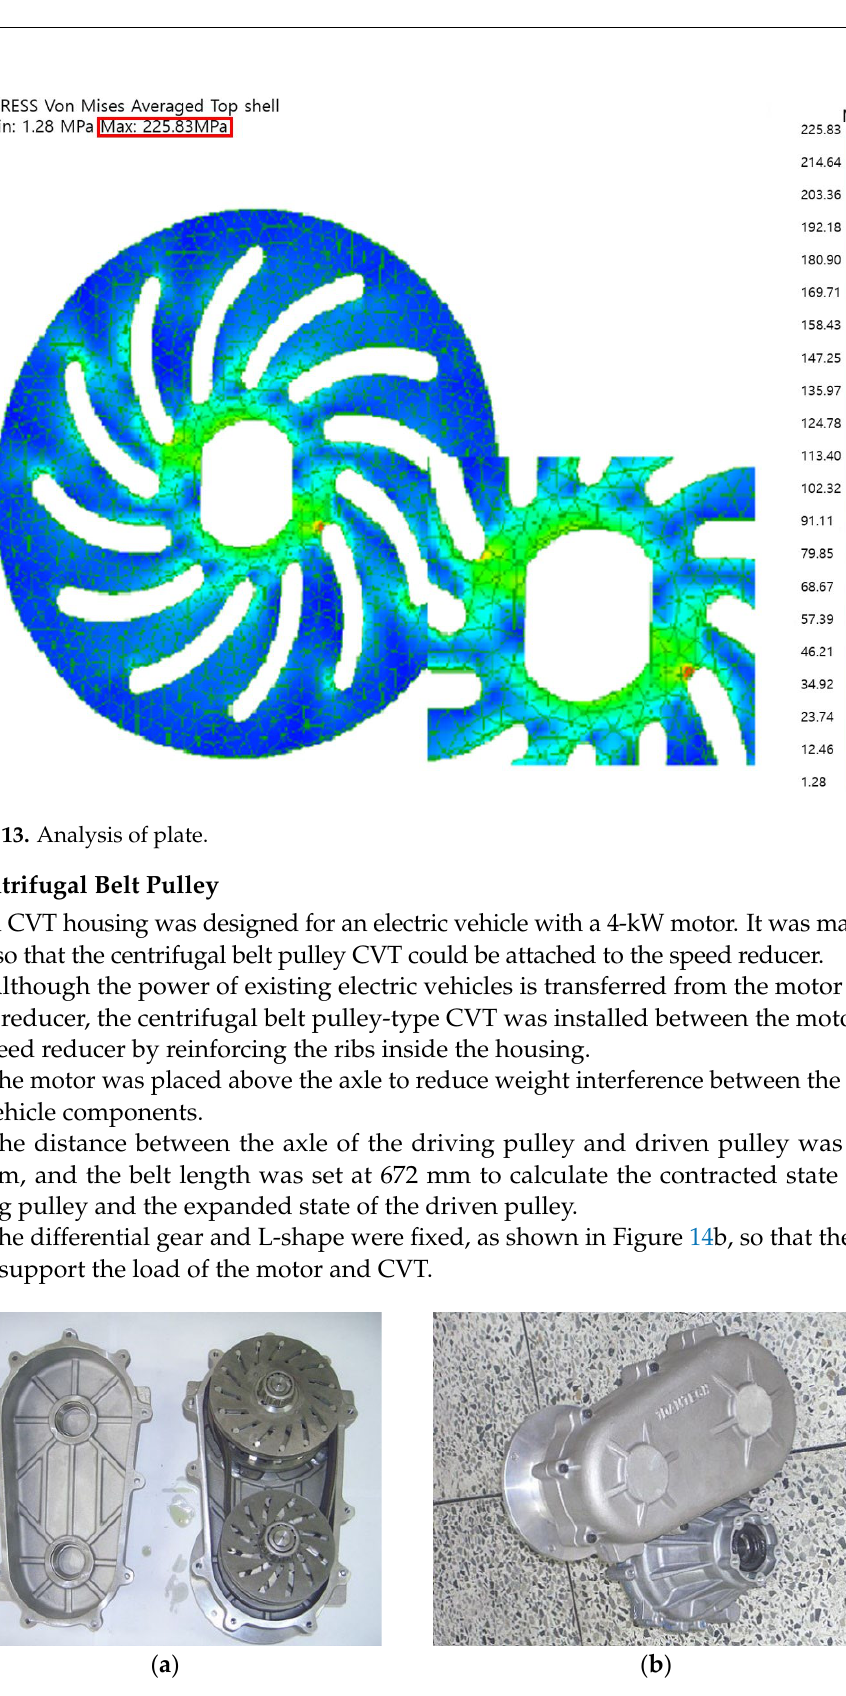
Figure 14. Prototype production: ( a ) inside of housing; ( b ) assembly of reducer and housing.